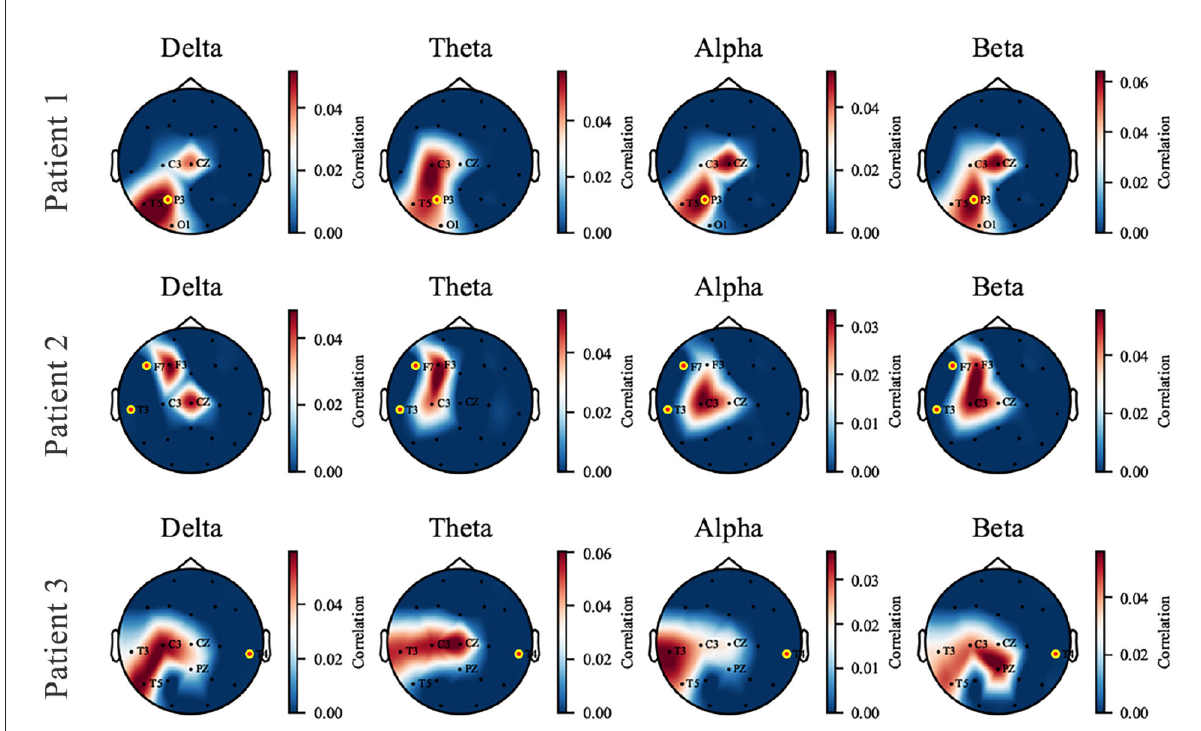
FIGURE6 The topological map of correlation coefficient from input-signal perturbation where red indicates a high correlation and blue indicates a low correlation. Four bands ( δ , θ , α , and β ) are investigated on each patient, and three of them are displayed as representatives. The names of available EEG channels for each patient are listed, and the channels nearby a seizure focus are marked with yellow-edged dots. Patients 1 and 2 are good examples that the sensitive zone (left parietal and temporal zone for Patient 1, left frontal and temporal for Patient 2) coincides with the seizure location, while Patient 3 is an exceptional case due to the missing of T4 channel in the dataset.